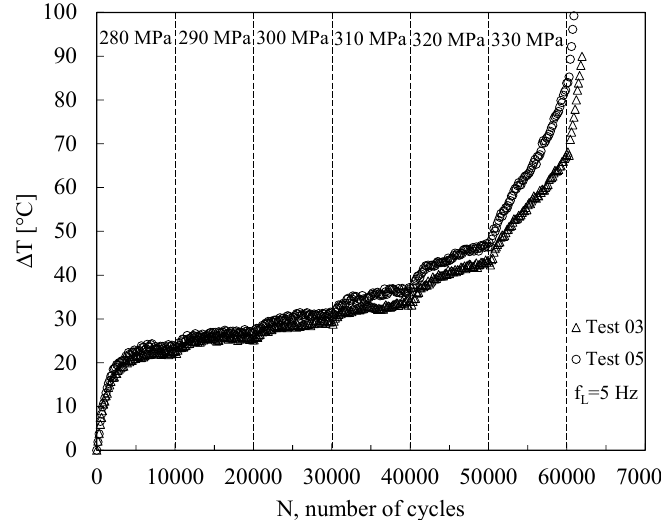
Figure 13. Example of temperature evolution measured during step-load fatigue tests carried out to estimate the material fatigue limit according to the Risitano method [5].